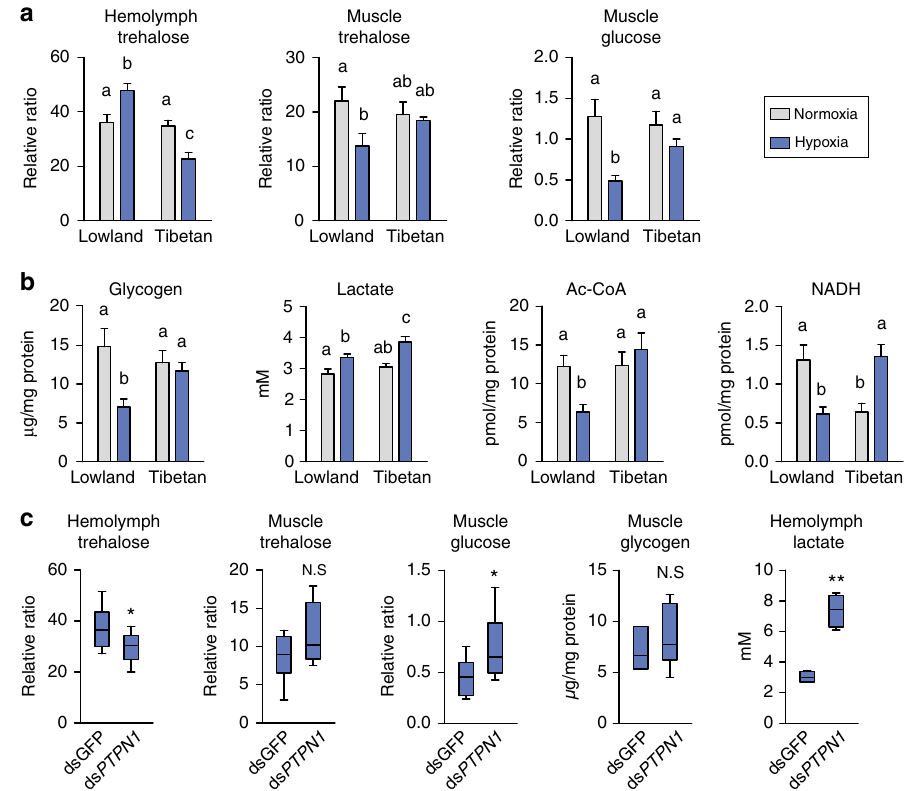
Fig. 5 Effect of PTPN1 mutation on energy metabolism alteration. a Trehalose level and glucose concentration in hemolymph and thoracic muscle. The relative ratio is the ratio of the peak area of metabolic intermediate to the peak area of the internal standard (sucrose). ( n ≥ 6 replicates, 3 locusts/ replicate). b The levels of glycogen, acetyl-CoA, and NADH in the thoracic muscle and lactate in hemolymph. Values in a , b are the mean ± s.e.m. Signi fi cant differences are denoted by letters (one-way ANOVA, P < 0.05) ( n = 4 replicates, 3 locusts/replicate). c PTP1B knockdown affected hypoxia- induced metabolic regulation by the insulin pathway ( n = 5 replicates, three locusts/replicate). * P < 0.05, ** P < 0.01 (Student ’ s t test). N.S. represents no signi fi cant difference (Student ’ s t test). The center line of the boxplots represents median value, the bounds of the box represent 75th and 25th percentile, and the whiskers represent maximum and minimum